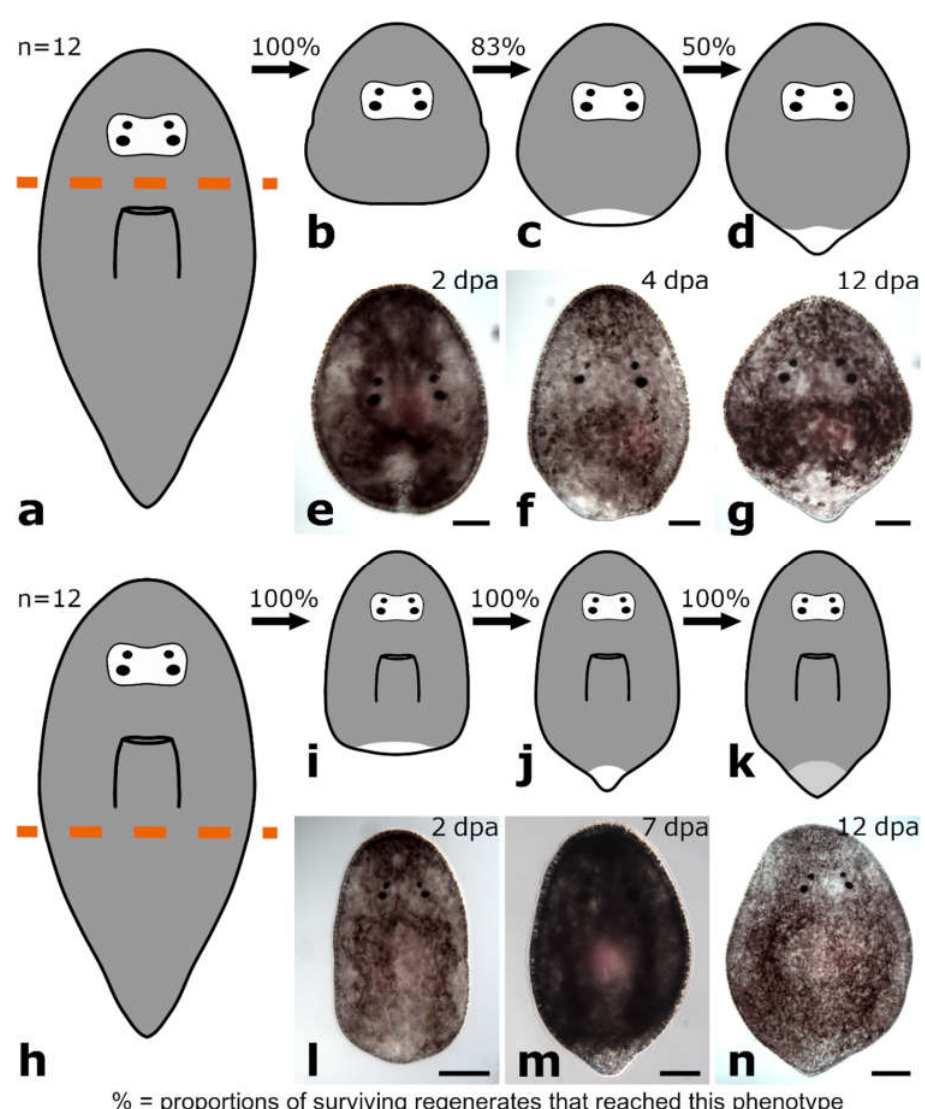
Figure 12. Regeneration in Protomonotresidae sp. Posterior regeneration after amputation between brain and pharynx ( a – g ). The wound was completely healed ( b , e ). A small, colourless blastema-like structure appeared ( c , f ) and developed into an unpigmented, pointy tail tip ( d , g ). Posterior regeneration after amputation posterior to the pharynx ( h – n ). The wound was fully healed and a small blastema-like structure appeared ( i , l ), which developed into a small pointy tail that lacked pigments ( j , m ). Pigments were restored in the regenerated tissue ( k , n ). Scale bars: 100 µm in ( l ) and ( n ); 50 µm in ( e – g ) and m .